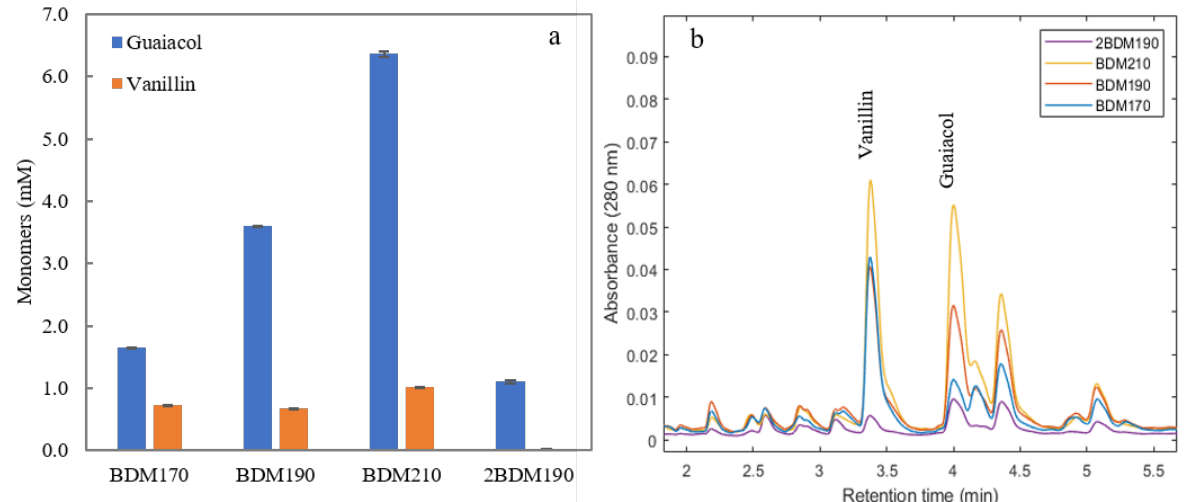
Figure 1. ( a ) Guaiacol and vanillin concentrations in the four permeate samples after membrane filtration of BLR depolymerized at three temperatures (BDM170, BDM190, BDM210, and 2BDM190). ( b ) The chromatograms obtained from UHPLC of the four samples. (Depolymerization was performed at temperatures of 170, 190, and 210 °C with 2 min residence time. The 2BDM190 sample is the permeate after ultrafiltration of the retentate from the first ultrafiltration of the BLR depolymerized at 190 °C.).